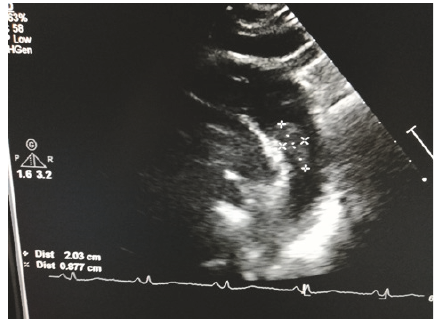
Figure 4: | Transesophageal echocardiography showed a 23mm mobile thrombus in the lesser curvature of aortic arch.